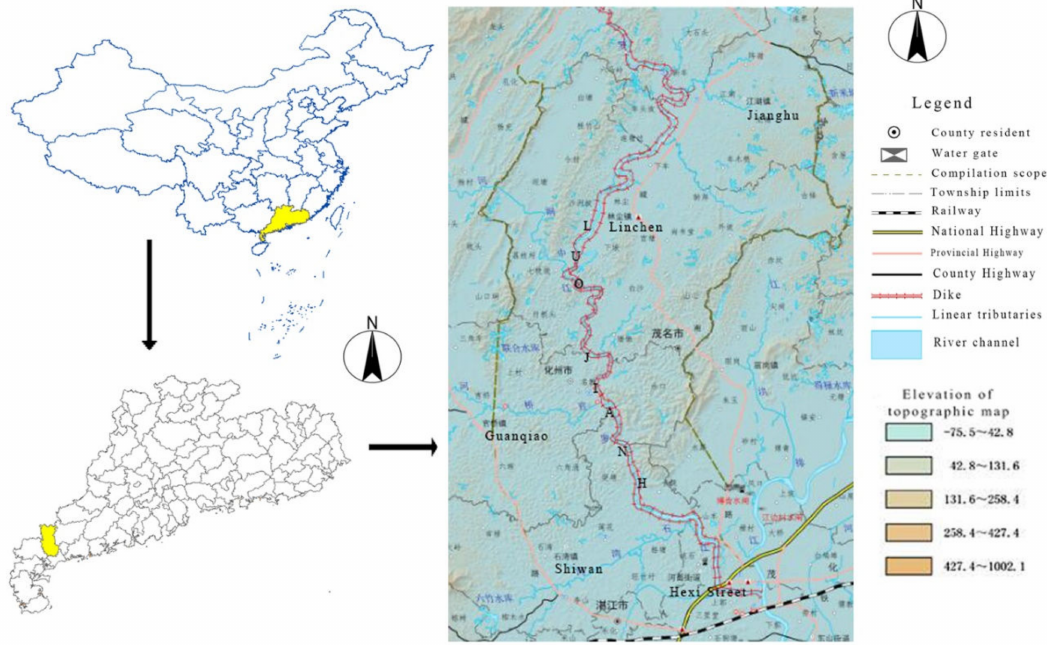
Figure 2. Geographic location of the section of Huazhou City in Luojiang River basin,